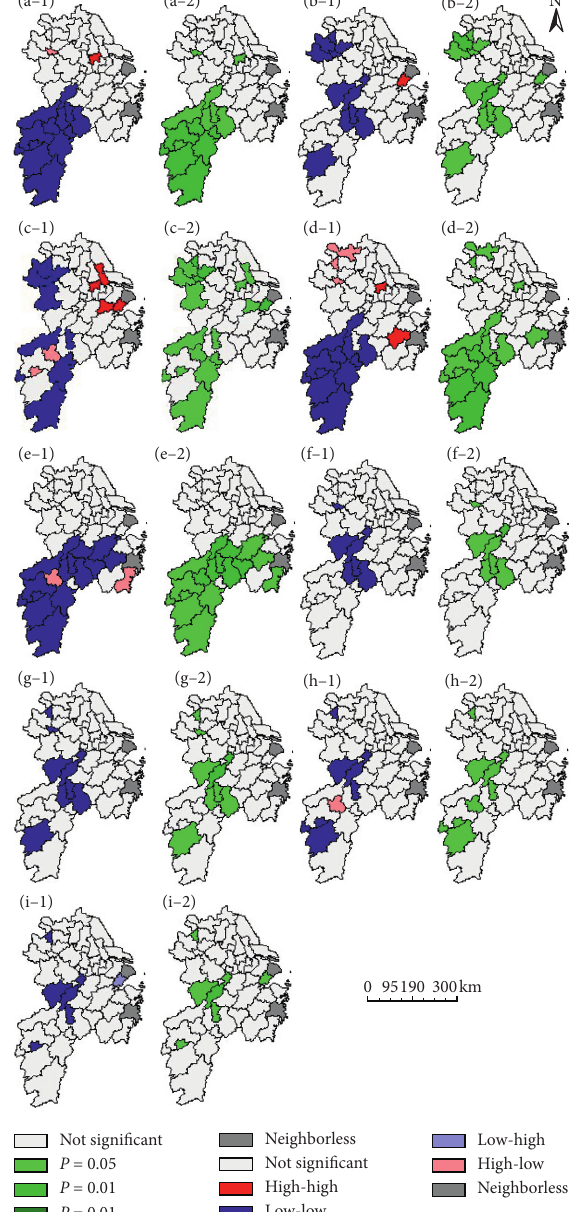
Figure 2: Spatial autocorrelation analysis of four provinces and one city in the lower reaches of the Yangtze river: ( ∗ -1) illustration of significance level; ( ∗ -2) illustration of spatial autocorrelation; (a) illustration of average salary; (b) illustration of GDP; (c) illustration of GDP per capita; (d) illustration of average salary in the municipal districts; (e) illustration of the built-up area per capita; (f) illus- tration of number of workers; (g) illustration of workers’ salary; (h) illustration of worker’s salary in municipal district; (i) illustration of number of workers in municipal